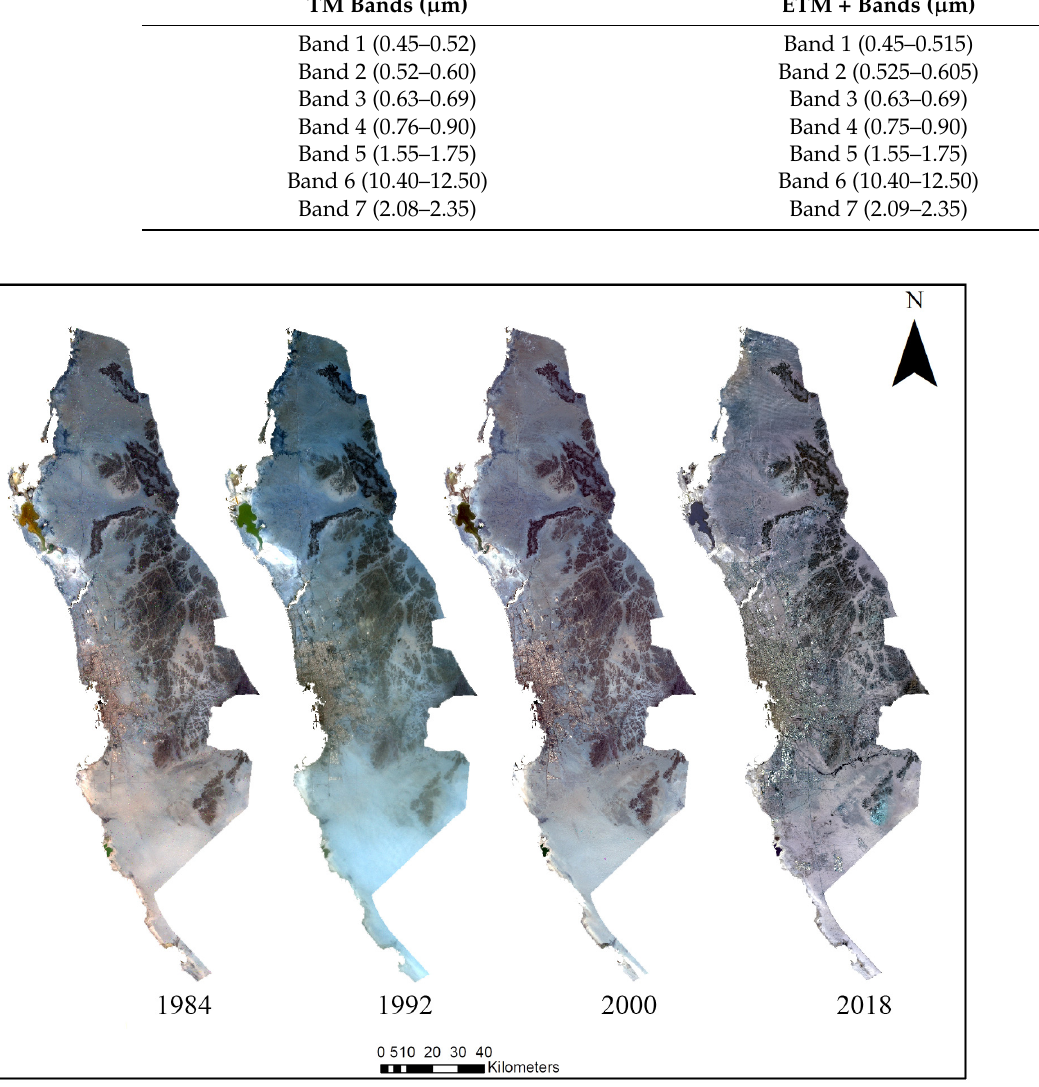
Figure 3. Landsat imagery for TM, ETM+, and OLI, presenting key development phases in Jeddah city through the time (1984–2018). Table 2. Landsat TM/ETM + spectral bands.